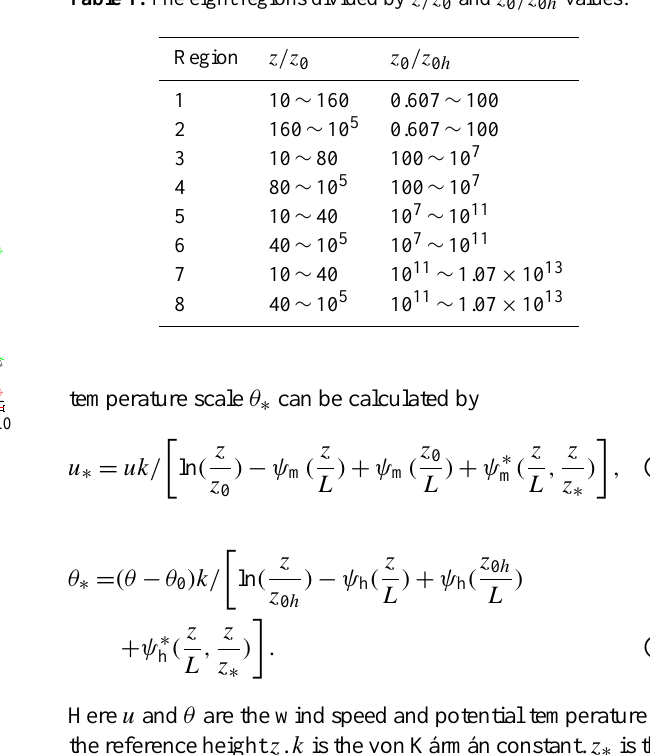
Table 1. The eight regions divided by z/z 0 and z 0 /z 0 h